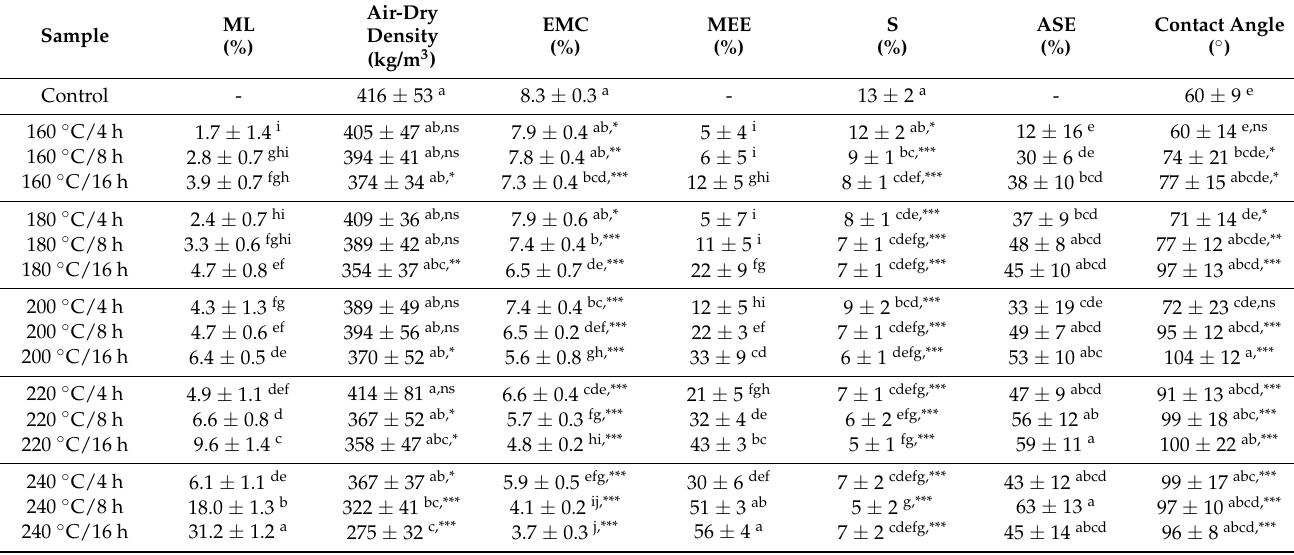
Table 1. Mass loss (ML), air-dry density, equilibrium moisture content (EMC), moisture excluding efficiency (MEE), volumetric swelling coefficient (S), anti-swelling efficiency (ASE), and contact angle of luanta fir wood after VH